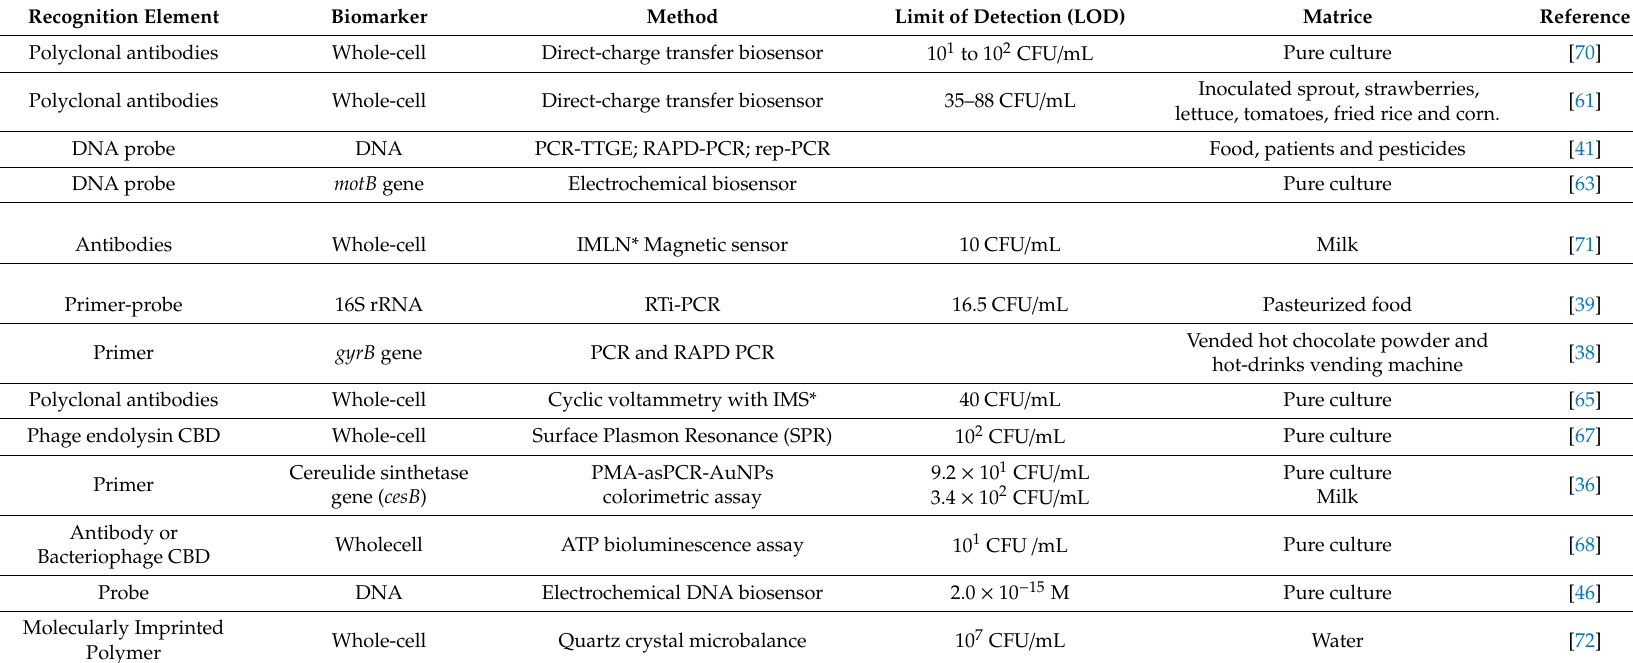
Table 1. Detection methods for B. cereus vegetative